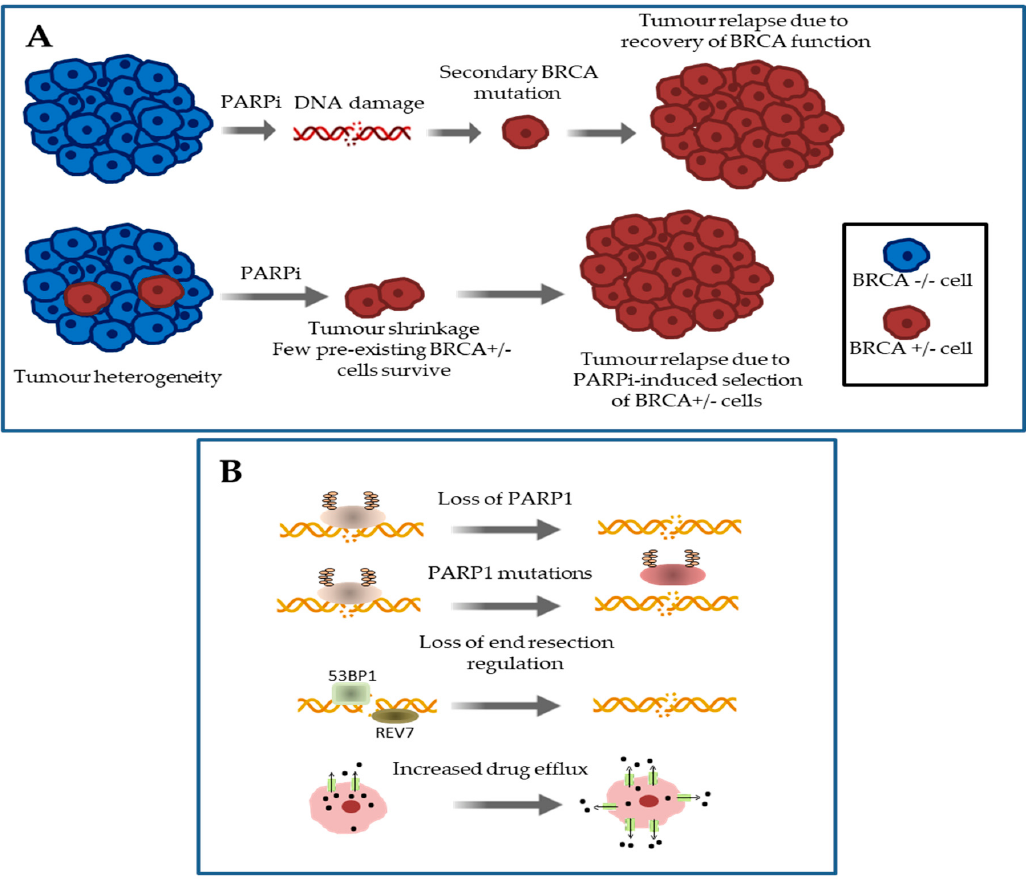
Figure 3. Mechanisms of resistance to PARPis. ( A ) BRCA-dependent mechanisms: (upper part) appearance of secondary “revertant” BRCA mutations (favored by increased DNA mutation rate) that restore the open reading frame and allow the synthesis of a functional BRCA protein; (lower part) PARPi-induced selection of pre-existing cells with “revertant” BRCA mutations. ( B ) BRCA-independent mechanisms: (from top to bottom) loss of PARP1 expression (often due to epigenetic mechanisms); appearance of PARP1 mutations altering PARP1 trapping; inactivation of the DNA repair proteins 53BP1 or REV7, resulting in the restoration of homologous recombination repair; increased expression of multidrug resistance